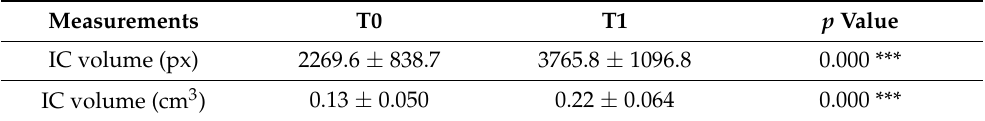
Table 5. Volume change in the IC after MARPE treatment (mean ± standard